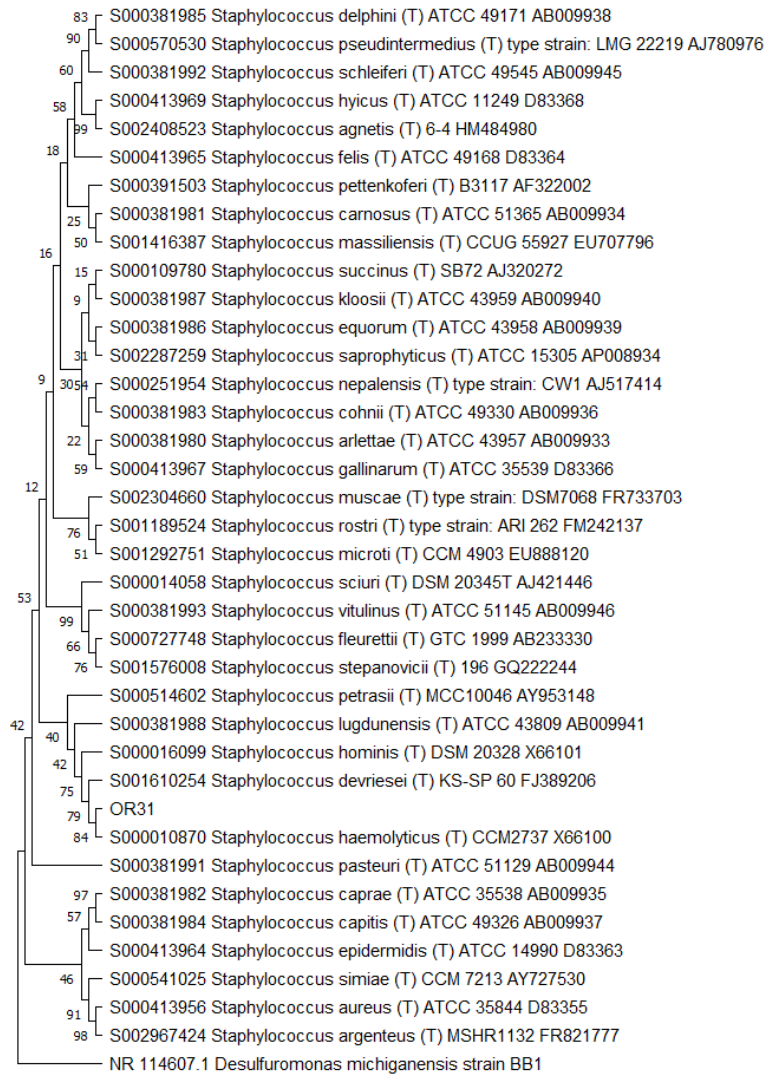
Figure 10. Phylogenetic tree for the genus Staphylococcus.